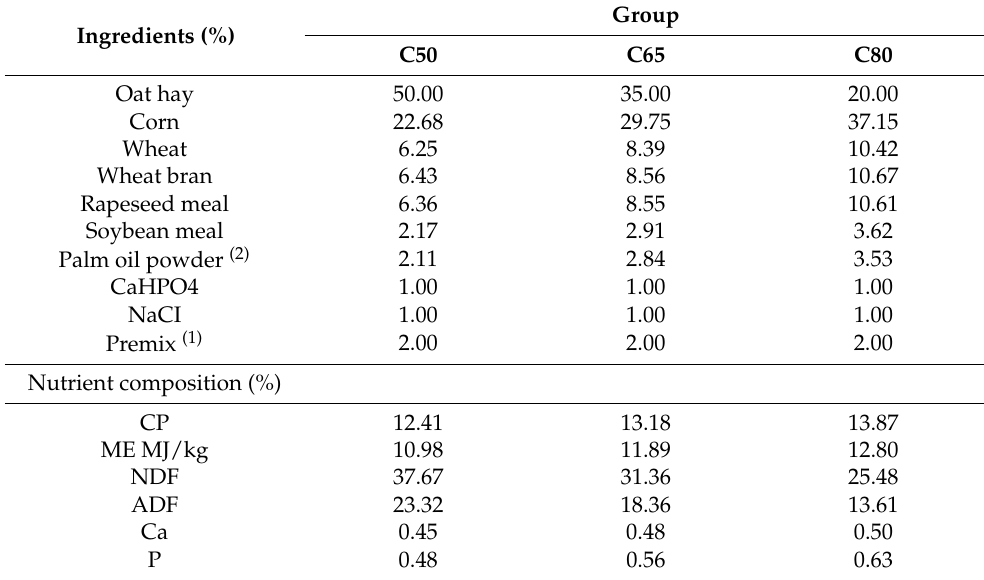
Table 1. Ingredients and nutritional composition of each diet